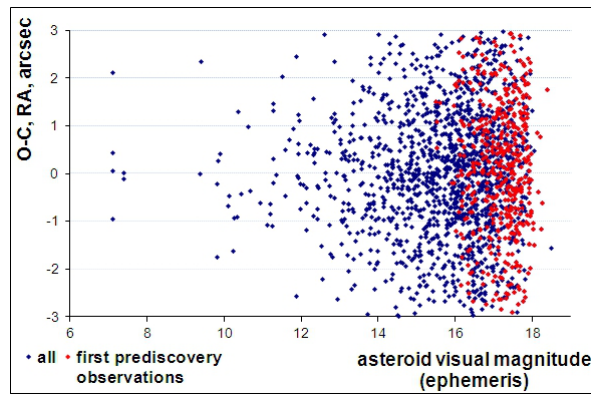
Figure 12. Distribution of O-C differences along right ascension for all and first prediscovery asteroid observations in the catalog.